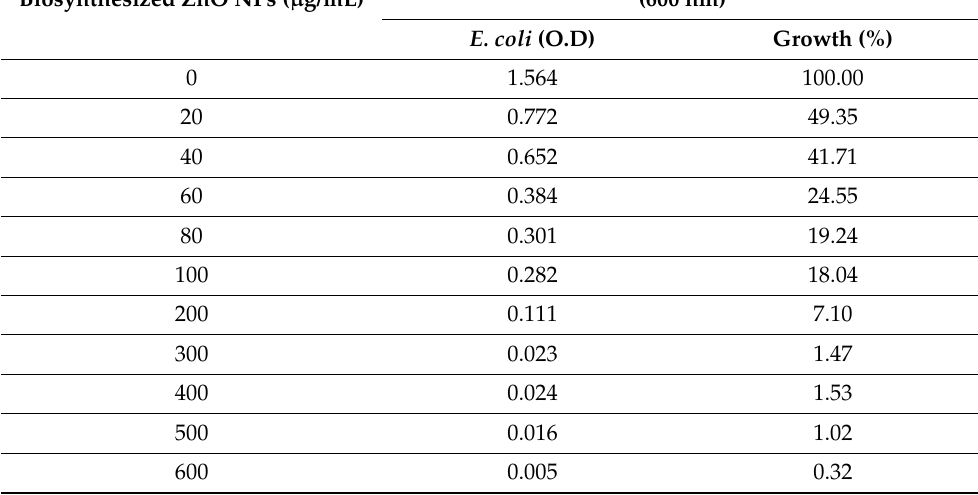
Figure 6. Cancer cell viability percentage on HCT-116 cell line at various concentrations of ZnO NPs.